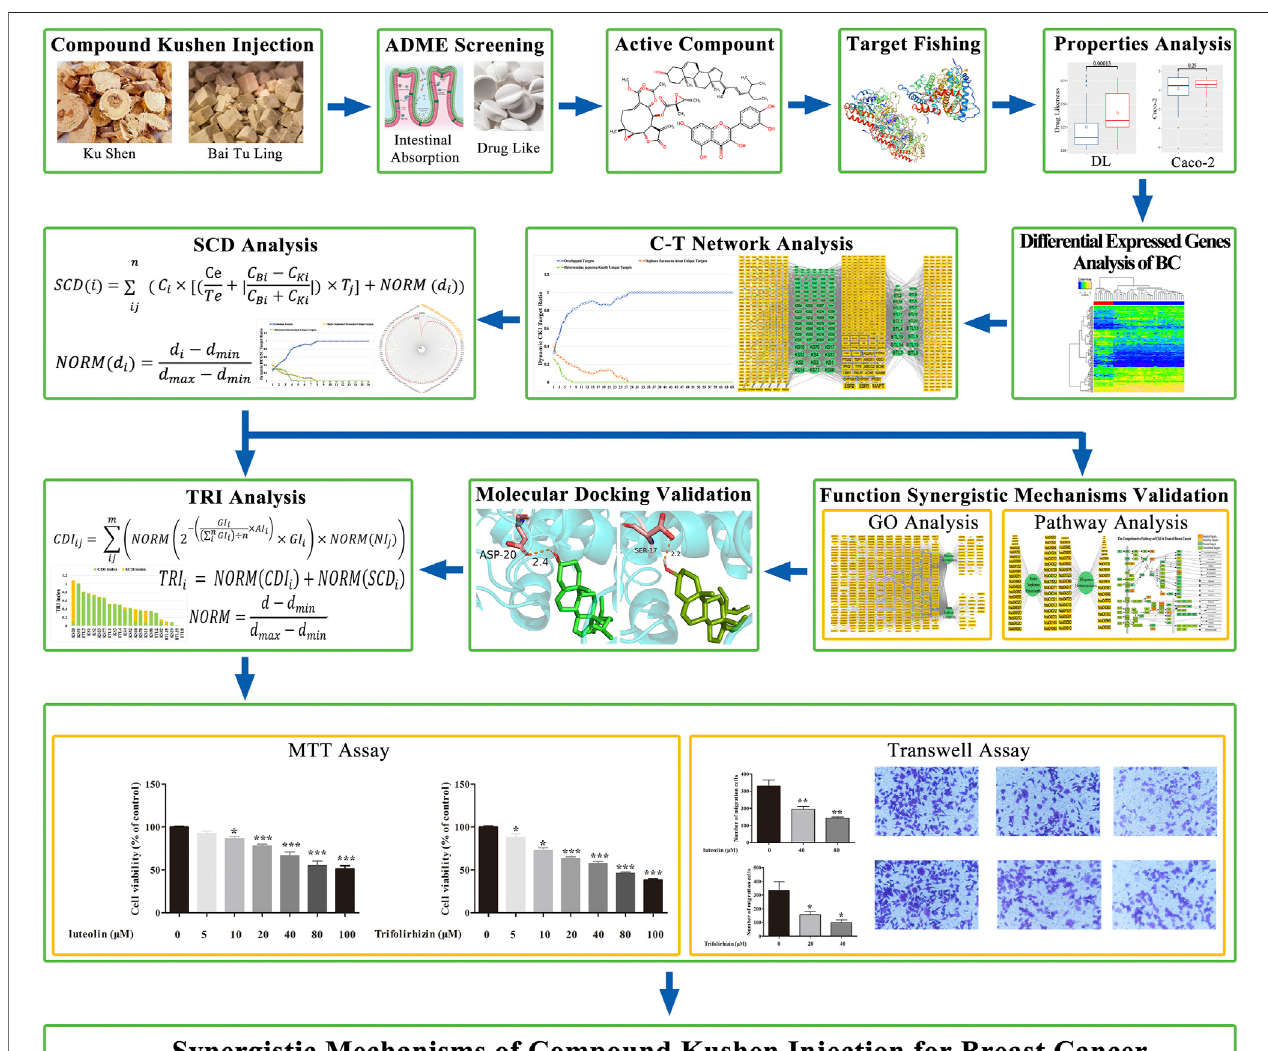
FIGURE 1 | Work fl ow of the system pharmacology